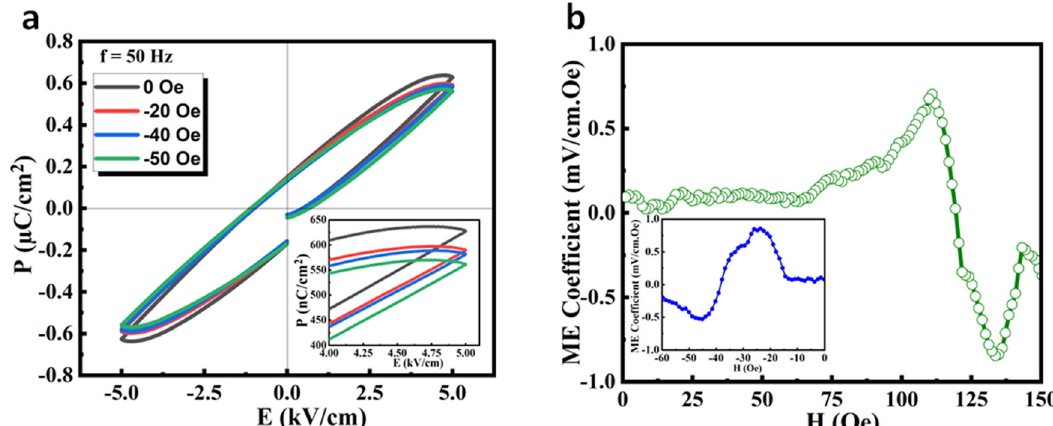
Fig. 5 Multiferroic and magnetoelectric effect. a The P – E loop in static magnetic fi eld at 50 Hz frequency. b The magnetoelectric coef fi cient versus applied DC magnetic fi eld at 5 Hz frequency of HT-Ti 3 C 2 T x MXene fi lm measured at room temperature.